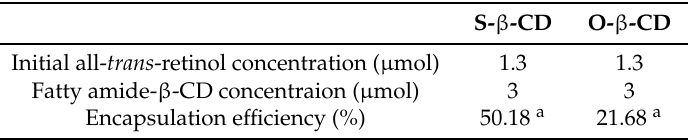
Figure 6. ( a ) FT-IR spectra (Inset shows the chemical structure of all- trans -retinol.); and ( b ) TGA curves for the free all- trans -retinol, S- β -CD, O- β -CD, all- trans -retinol/S- β -CD nano-vesicle composites, and all- trans -retinol/O- β -CD nano-vesicle composites. Table 2. Encapsulation efficiency of S- β -CD and O- β -CD.